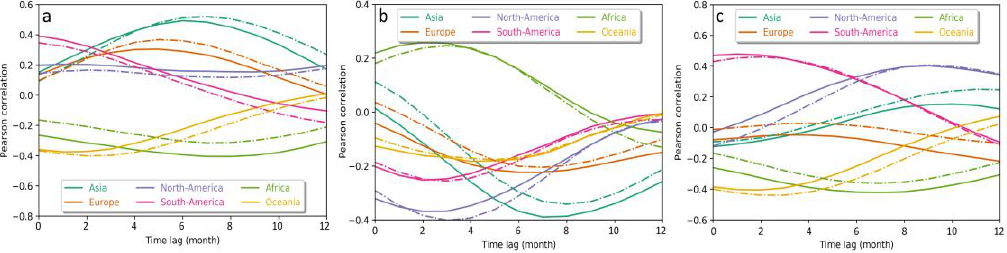
Figure A7. Global vegetation map and continental boundaries as well as atmospheric CO 2 observa- tion stations. A total of 13 PFTs are defined in CCDAS and the major PFT for each grid cell is shown here. The continental boundaries are depicted with rectangles, green color for North America, red color for South America, yellow color for Europe, purple color for South Africa, blue color for Asia, and brown color for Oceania. The red dots are for the SIO atmospheric CO 2 observation stations from which the data are used in the assimilation.